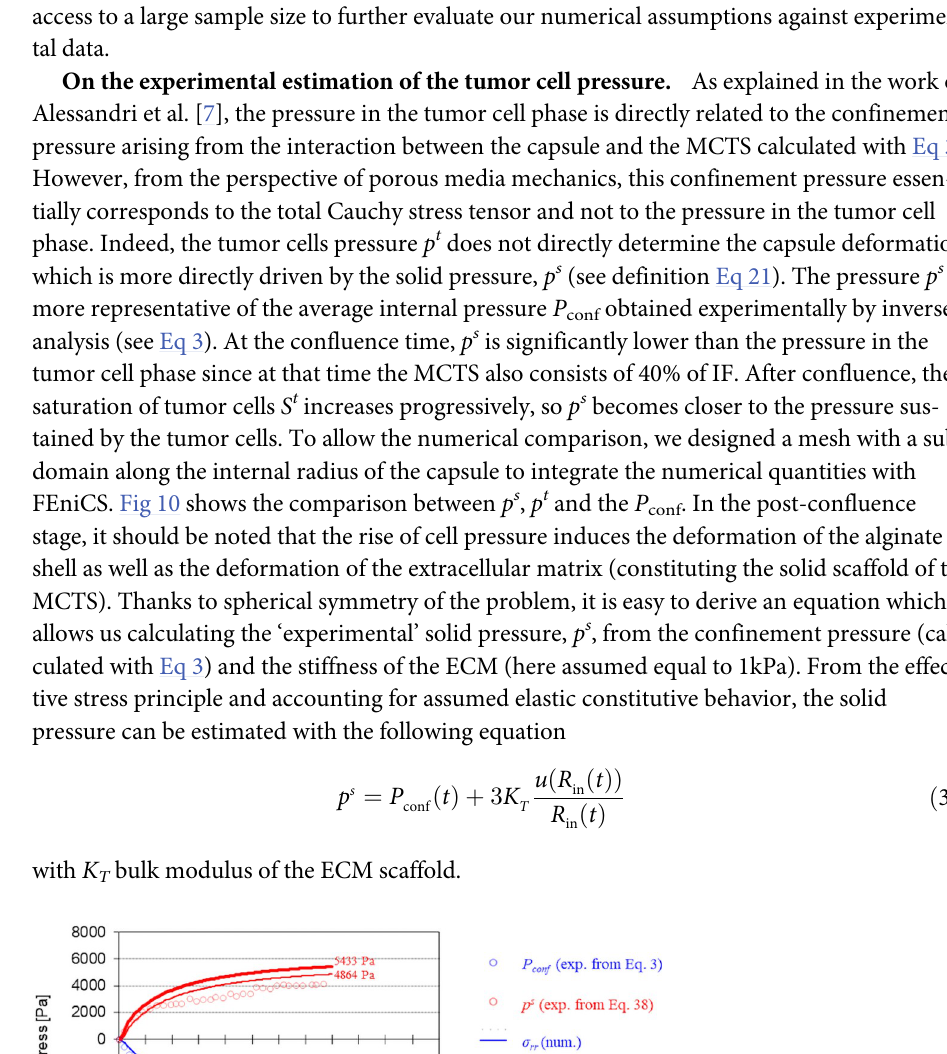
, p s and p t obtained rr